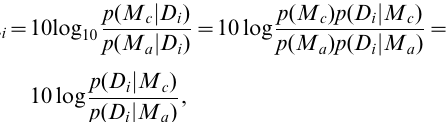
Figure S1 Best-fit 2D variance ellipses for subjects not shown in Figure 2. Found at: doi:10.1371/journal.pcbi.1000982.s001 (2.06 MB EPS) Figure S2 Additional subjects not contained in Figure 3. Found at: doi:10.1371/journal.pcbi.1000982.s002 (0.37 MB